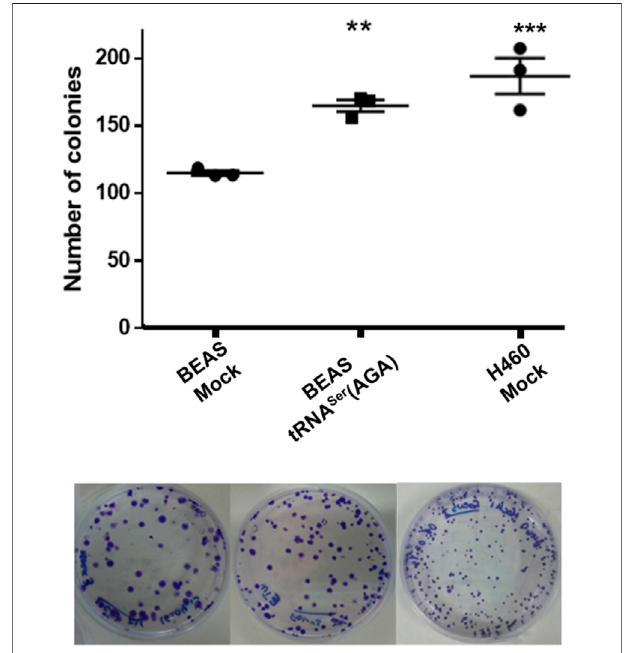
FIGURE 3 | tRNA Ser (AGA) upregulation increases the transforming potentialofnormalcells invitro .Upperpanel,quanti fi cationofcoloniesinthree biological replicates per condition. Lower panel, Representative anchorage- dependent colony formation plates used for quanti fi